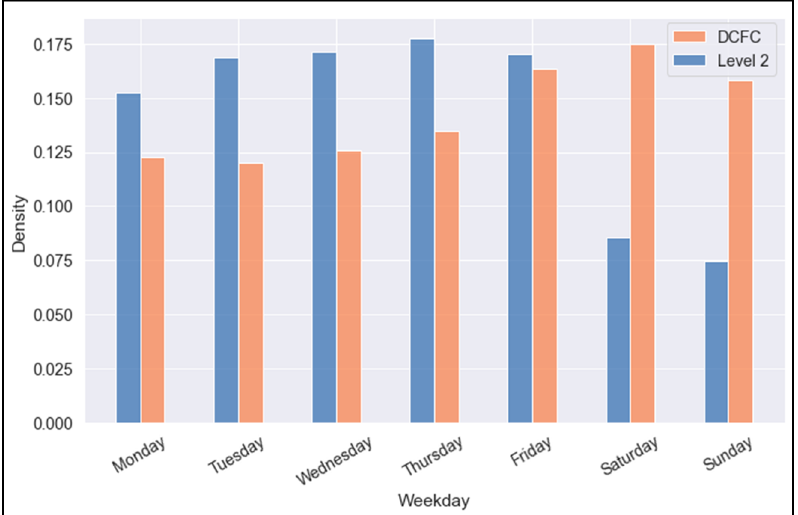
Figure 9. Distribution of DCFC and Level 2 charging event counts over day of the week.